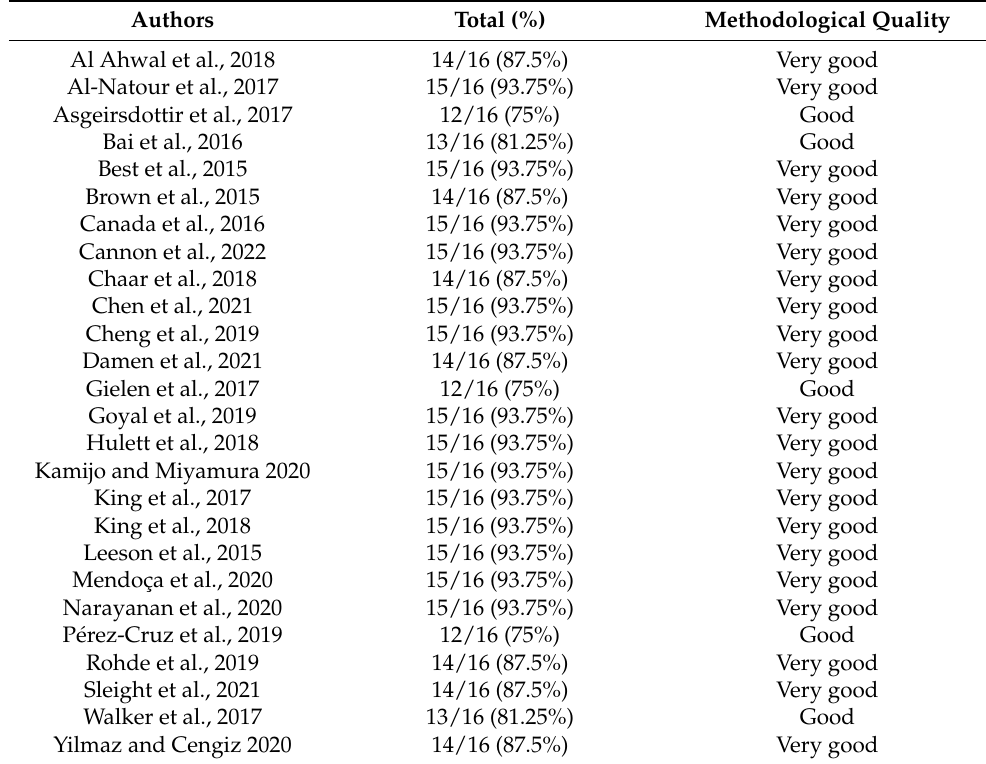
Table 1. Methodological quality of the articles included in the